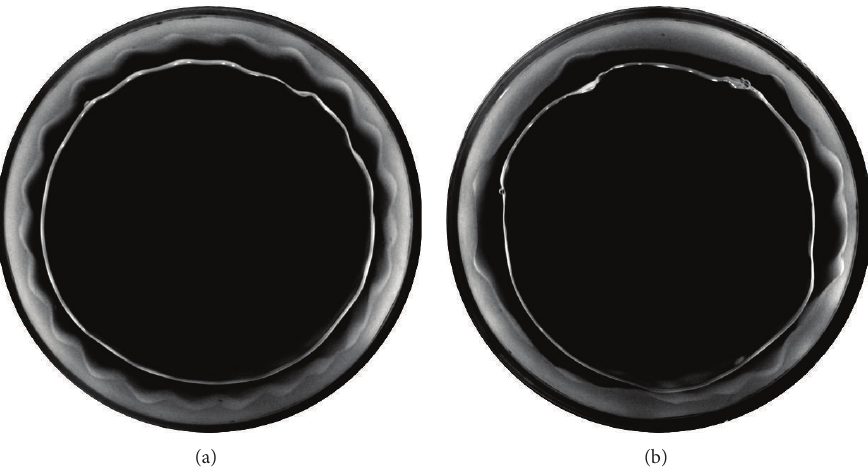
Figure 6: Time evolution of ripples at the liquid-sand interface: 𝑡 = 1 min (a) and 60min (b); 𝑞 = 0.257 , ] = 3.2 cSt, 𝑚 = 250 g, and Ω = 33.0 s −1 .